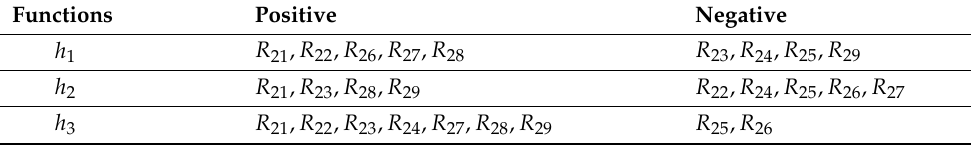
Table 5. Signs of functions h 1 , h 2 and h 3 in the subregions of R 2